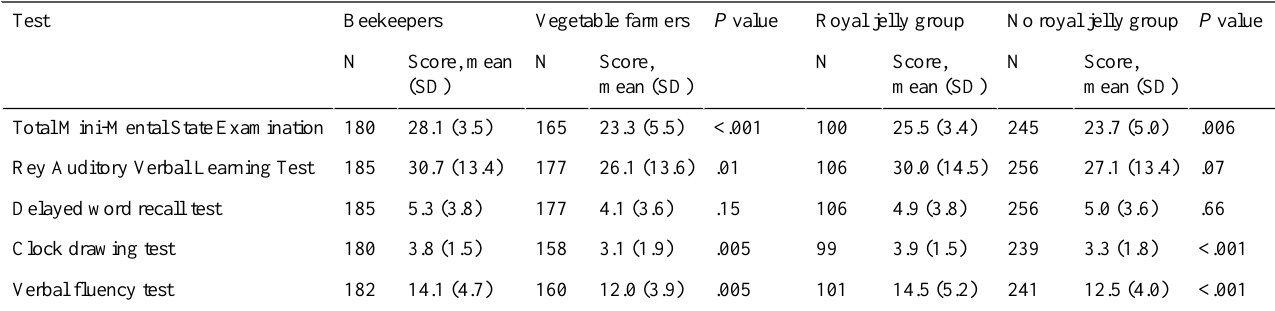
Table 6. Results of cognitive function survey in beekeepers and vegetable farmers from Wuhan, China (sampled between February and April 2016).